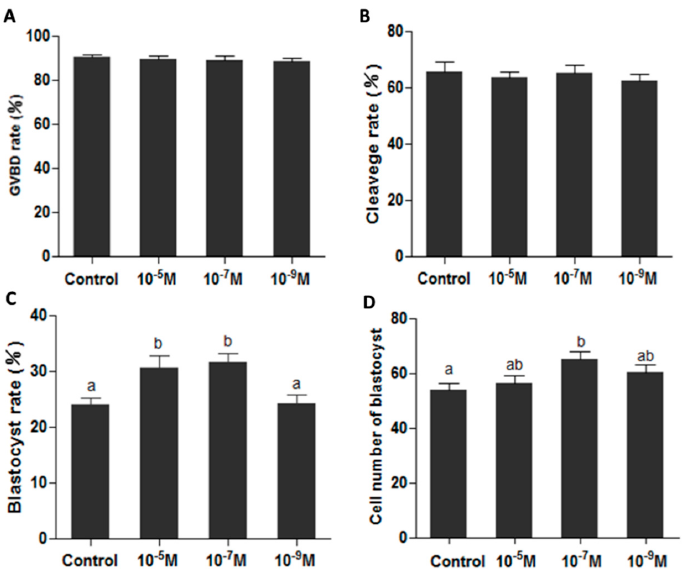
Figure 3. Effects of melatonin on oocyte’s maturation and subsequent IVF embryo development. ( A ) Effect of melatonin on GVBD rate (the percentage of GVBD oocytes); ( B ) Effects of melatonin on IVF embryonic development; ( C ) Effects of melatonin on blastocyst rate; ( D ) Effects of melatonin on the cell numbers of blastocysts (mean ± SEM of 1650 oocytes). The different superscript letters (a–b) represent a significant difference of these columns ( p < 0.05).